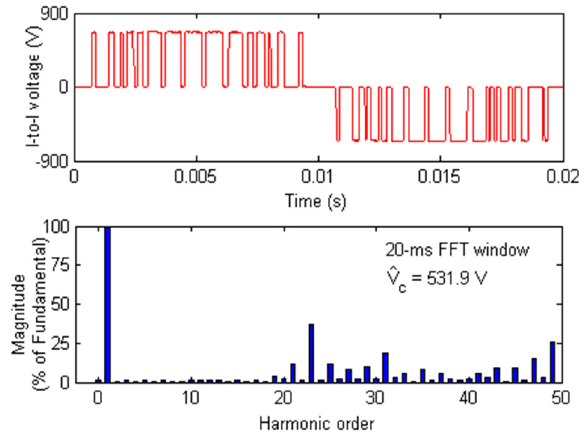
Figure 14. Line ‐ to ‐ line (l ‐ to ‐ l) voltage output of the VSC at the top when V dc = 667 V, and its harmonic spectrum at the bottom.